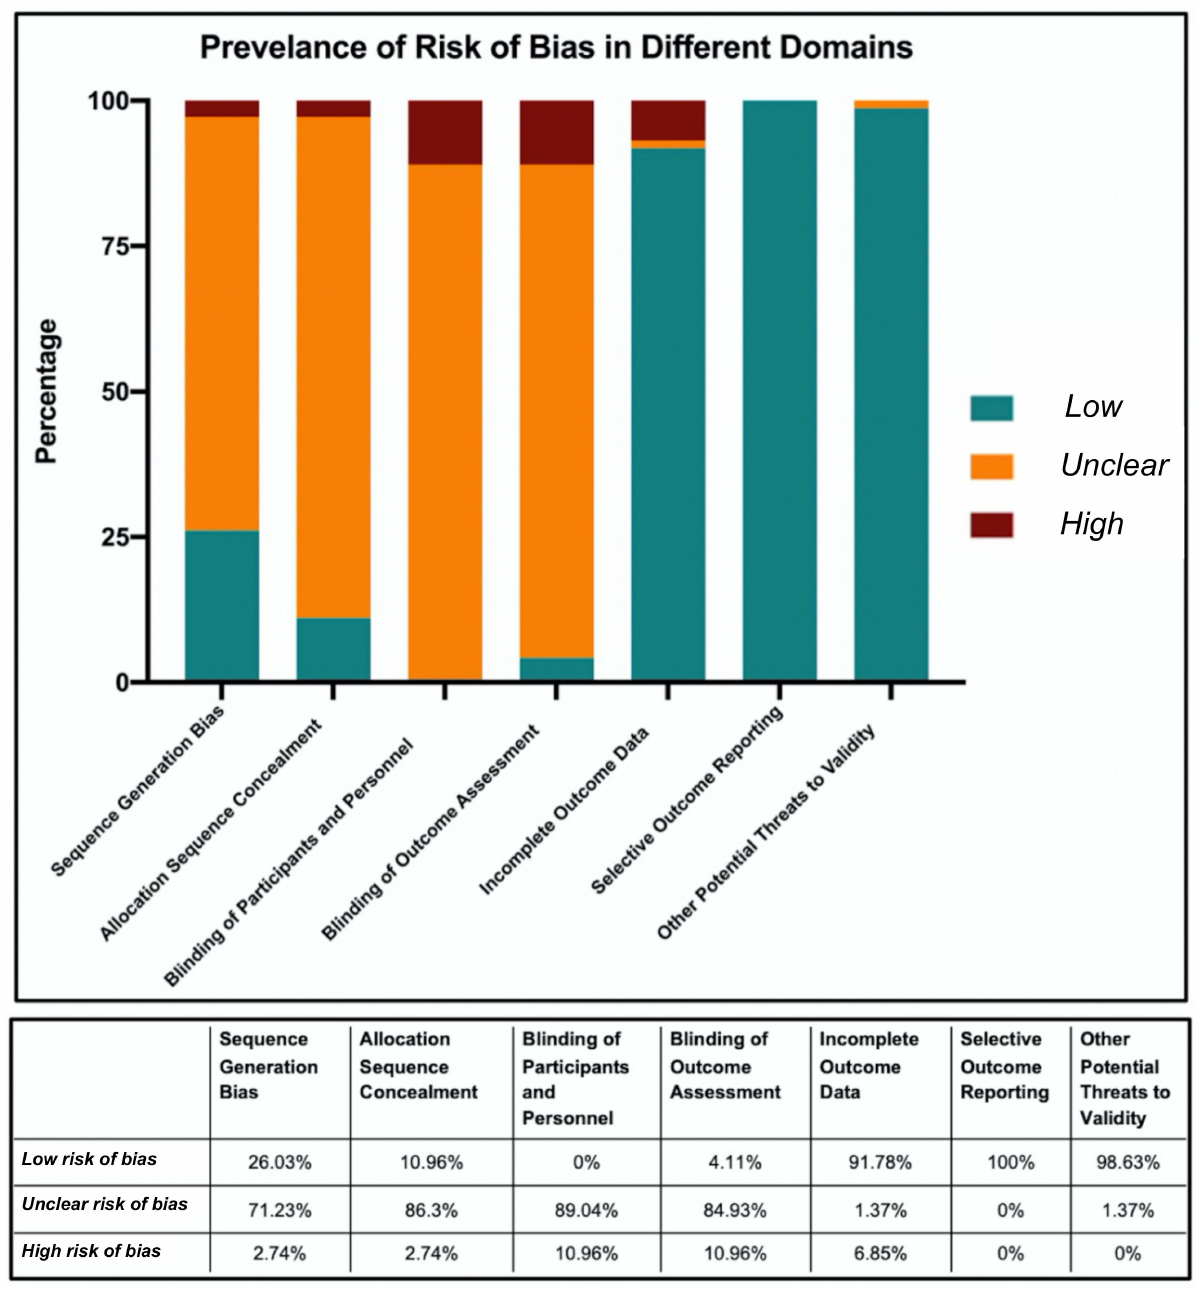
Figure 3. Prevalence of risk of bias in seven different domains among all RCTs published in osteosarcoma and Ewing’s